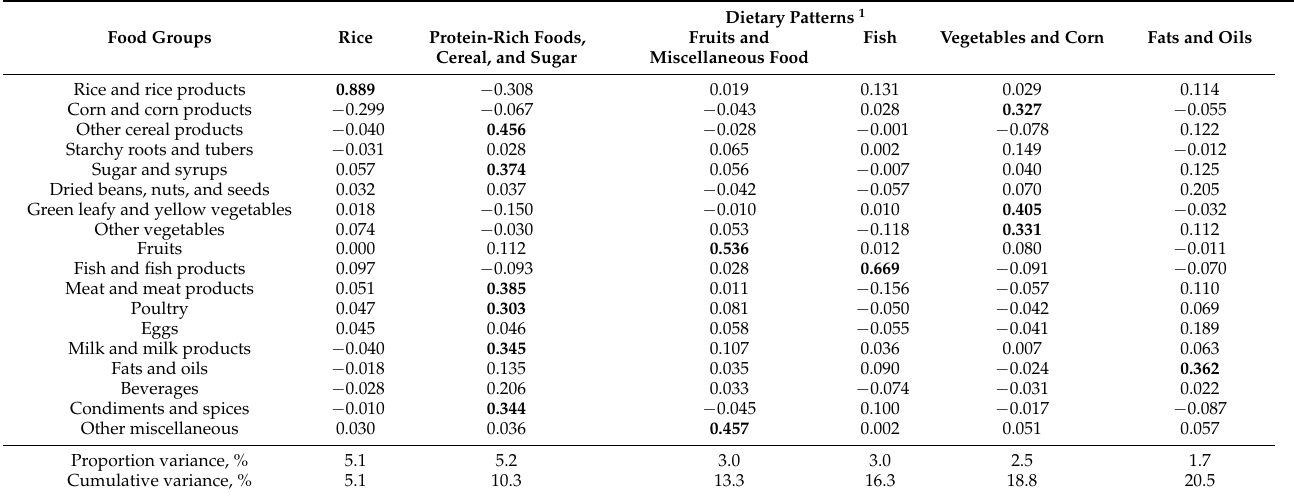
Table 4. Factor loadings for the six dietary patterns identified among